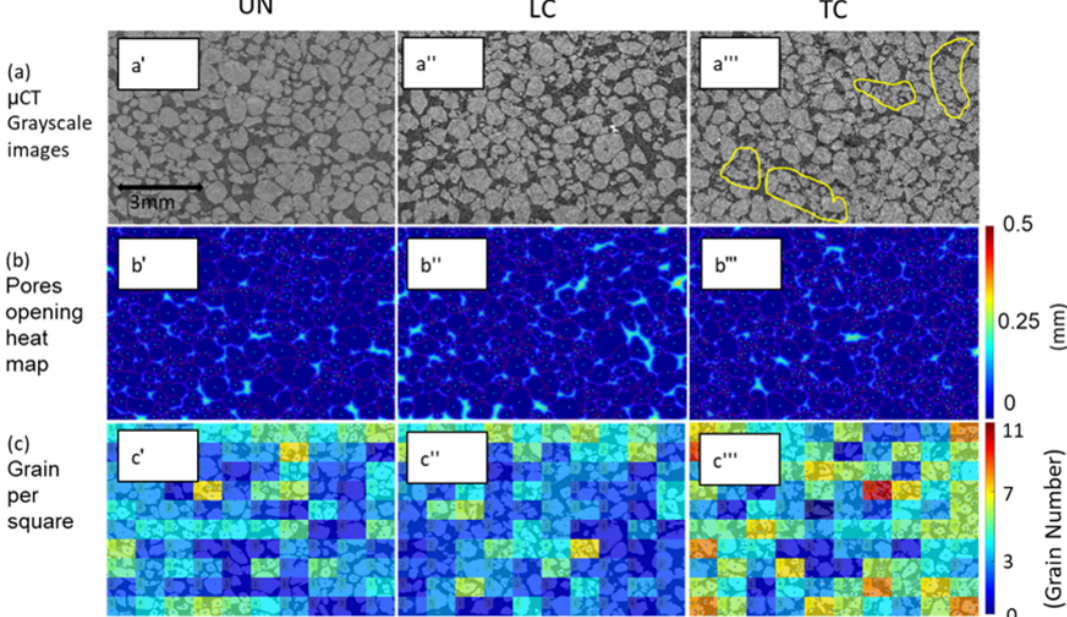
Figure 3. (a) µCT grayscale cross-section scans; (b) pore openings heat maps; and (c) grain number spatial distribution maps for the uncompacted ( (cid:48) ), low ( (cid:48)(cid:48) ), and top ( (cid:48)(cid:48)(cid:48) ) levels of compacted soil samples, respectively. Yellow contours in ( a (cid:48)(cid:48)(cid:48) ) indicate areas with high levels of grain breakage. In (b) , the blue dots represent the grain centers, and the color bar indicates the distance within the pores from the nearest grain. In (c) , the rectangles are colored in proportion to the number of grains in each one of